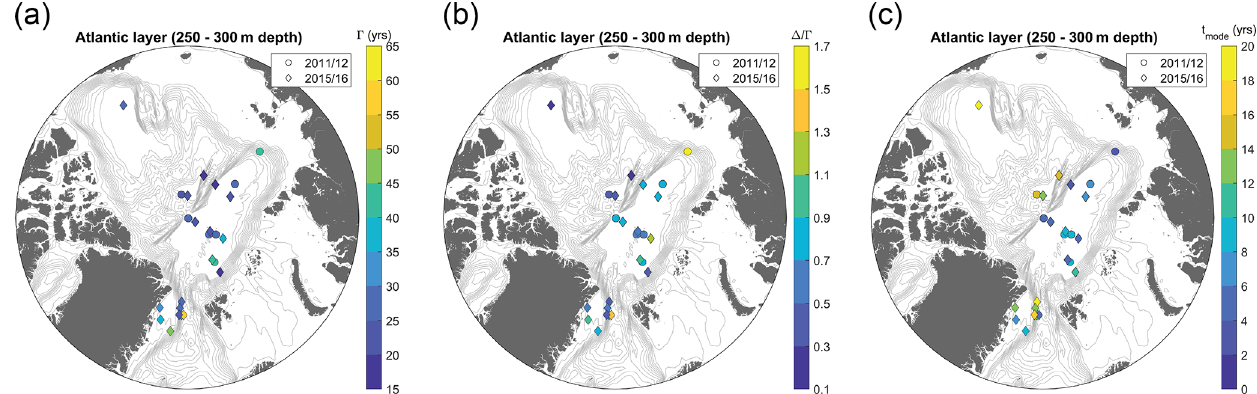
Figure 6. (a) Mean ages (cid:48) , (b) (cid:49)/(cid:48) ratios, and (c) mode ages t mode determined from the TTD model for individual stations in the Atlantic layer (250–300m depth and 500m depth for the Canada